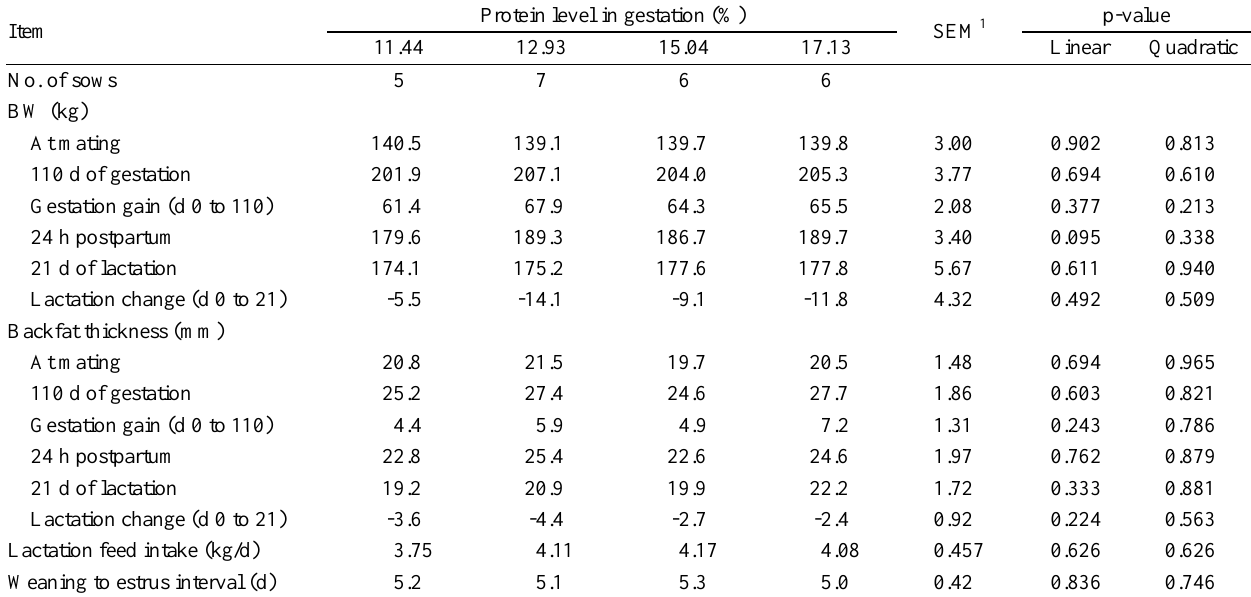
Table 2. Effect of CP levels in gestation diets on BW, backfat thickness and weaning to estrus interval of gilts in gestation and lactation